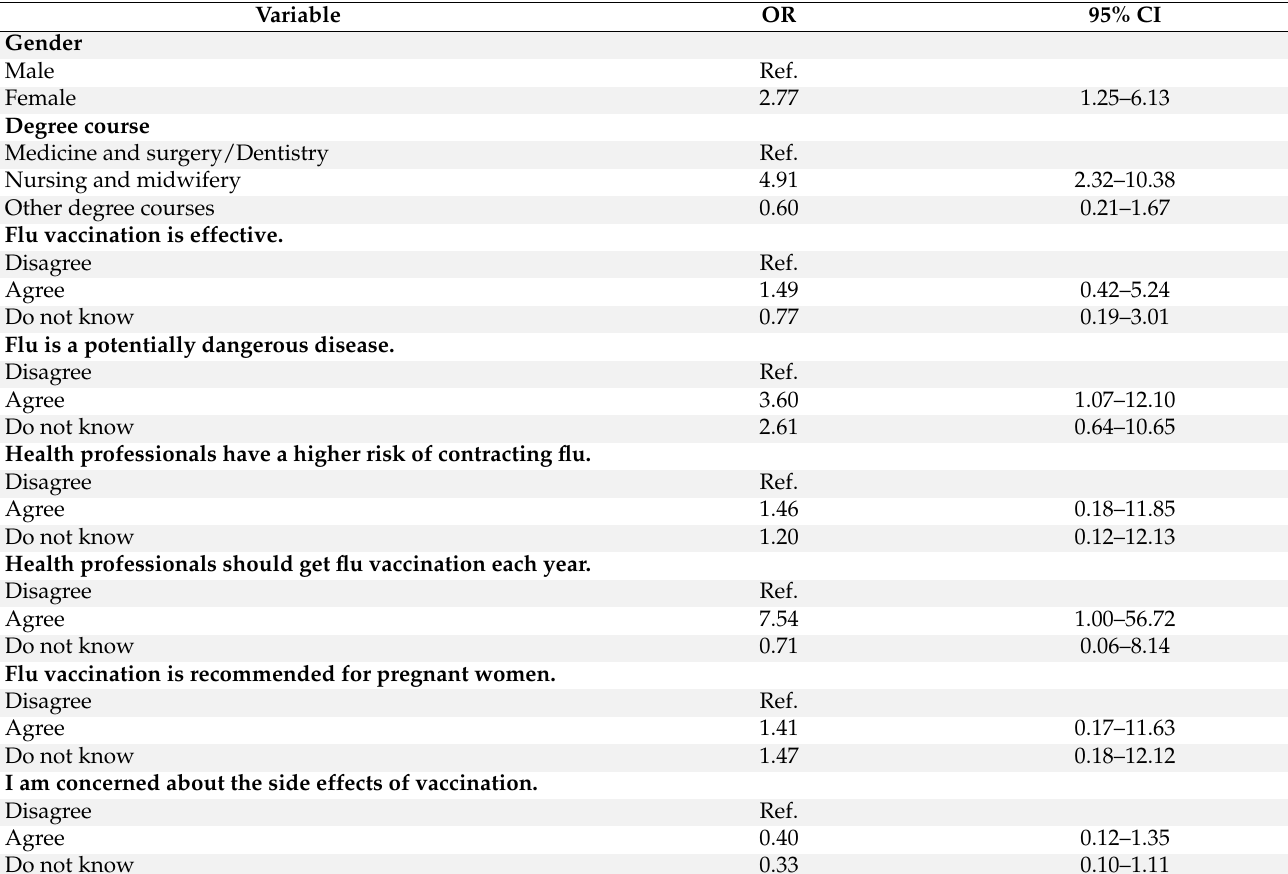
Table 5. Univariate logistic regression analysis of the variables associated with the adherence to vaccination during the 2018–2019